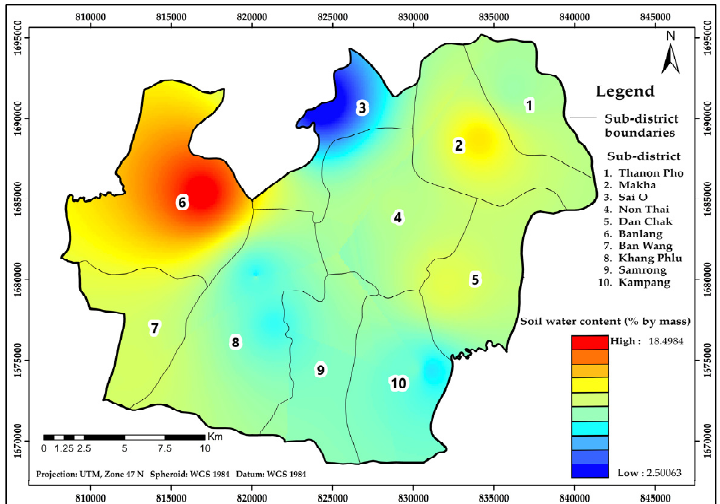
Figure 5. Spatial distribution of soil moisture content in the study area .